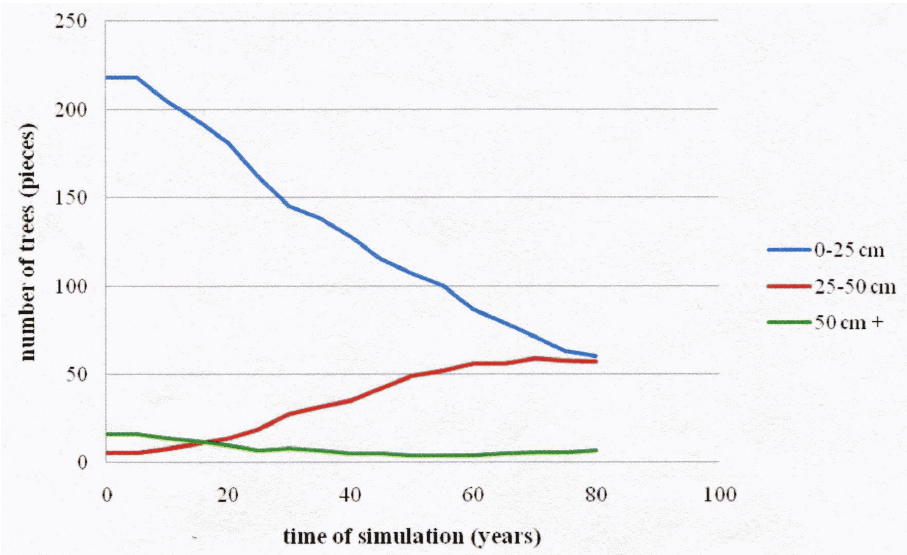
Figure 8. Prediction of time changes in standing tree volumes (m 3 .ha -1 ) for both study sites: Jeleni Bucina (solid line) and Bucina pod Frantiskovou Myslivnou (dashed